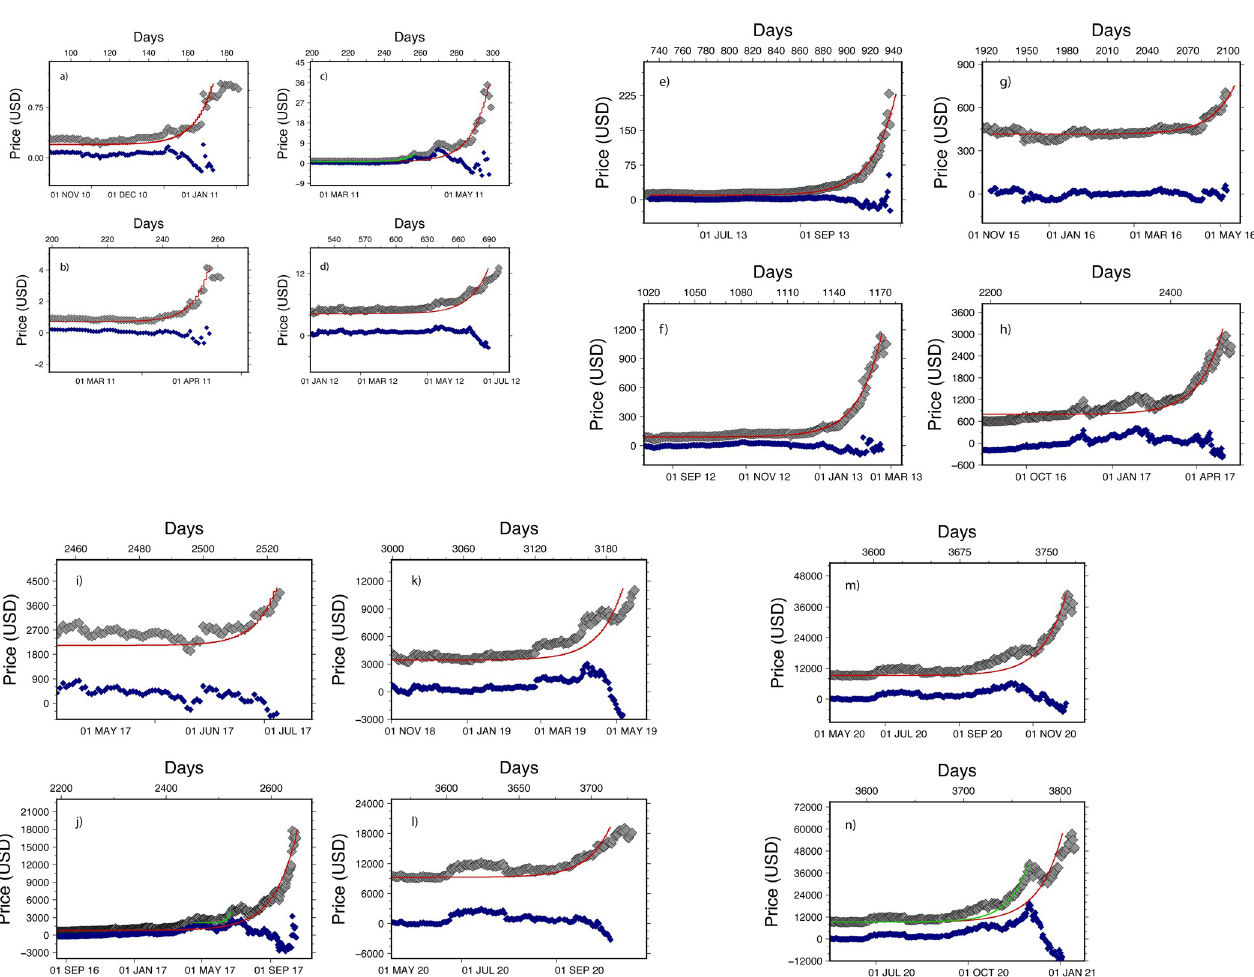
Fig 5. BTC pricing events presented in this study. Observed prices are plotted using grey diamonds triangles, modelled prices using red lines. Preceding events are shown using green lines. Residuals are shown using blue diamonds. All curves and residuals parameters are shown in Table 1. On panel j), we show for comparison the fitted curve (in green) shown in panel i). Panel m) shows that more research needs to be done to understand the mechanism of each event. If the data of panel m) can be well modeled, the next peak is more difficult to fit (red line; Table 1). Here we have unique opportunity to see to simultaneous events and may need to be studied in more detail.